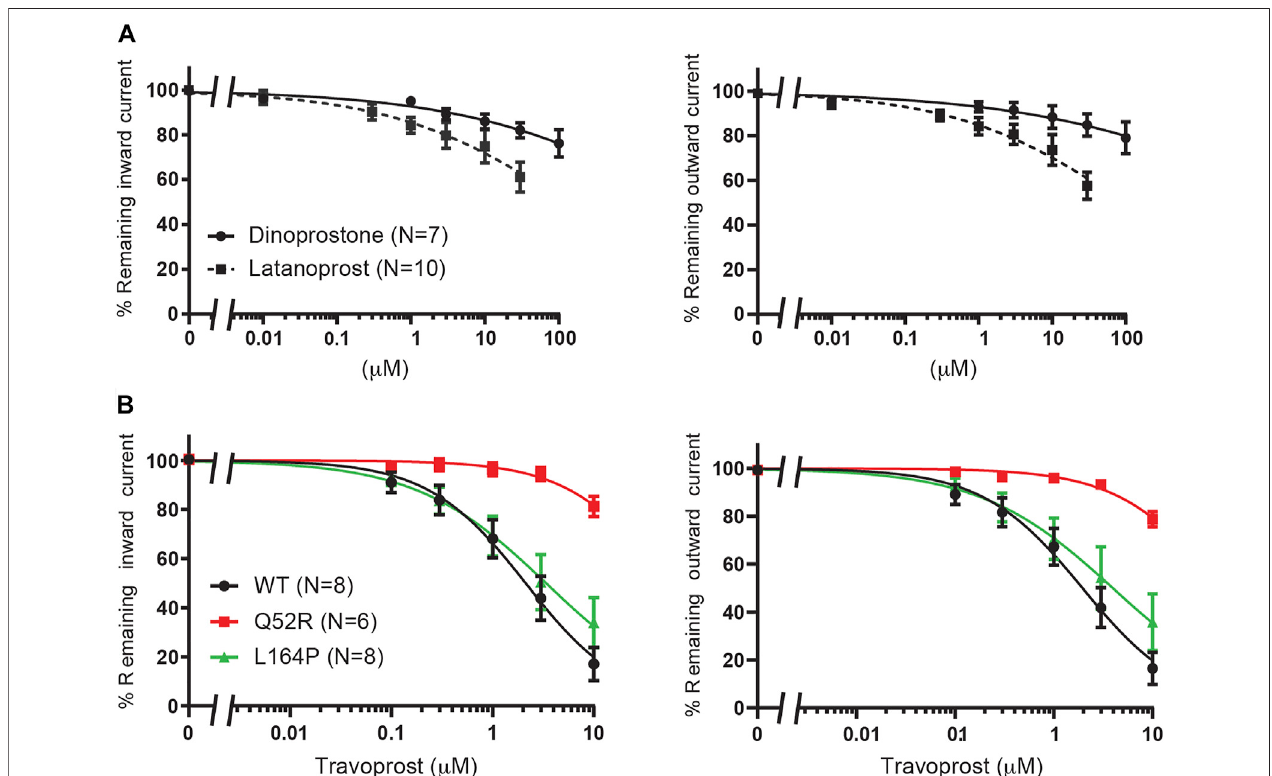
FIGURE6| EvaluationofK IR 6.2/SUR2adependent currentsinresponsetodinoprostone,latanoprostandtravoprost. (A) IC 50 curvesofWTK IR 6.2/SUR2ainward (at − 80 mV),leftpanel,andoutward(at+50 mV),rightpanel,currentinhibitioninresponsetoincreasingconcentrationsofdinoprostoneorlatanoprost. (B) IC 50 curvesof WT, Q52R and L164P K IR 6.2/SUR2a inward (at − 80 mV), left panel, and outward (at +50 mV), right panel, current inhibition in response to increasing concentrations of travoprost. Data were fi tted with Hill equation to estimate the IC 50 values. Data are shown as mean ± SEM. N depicts number of measurements on independent inside-out